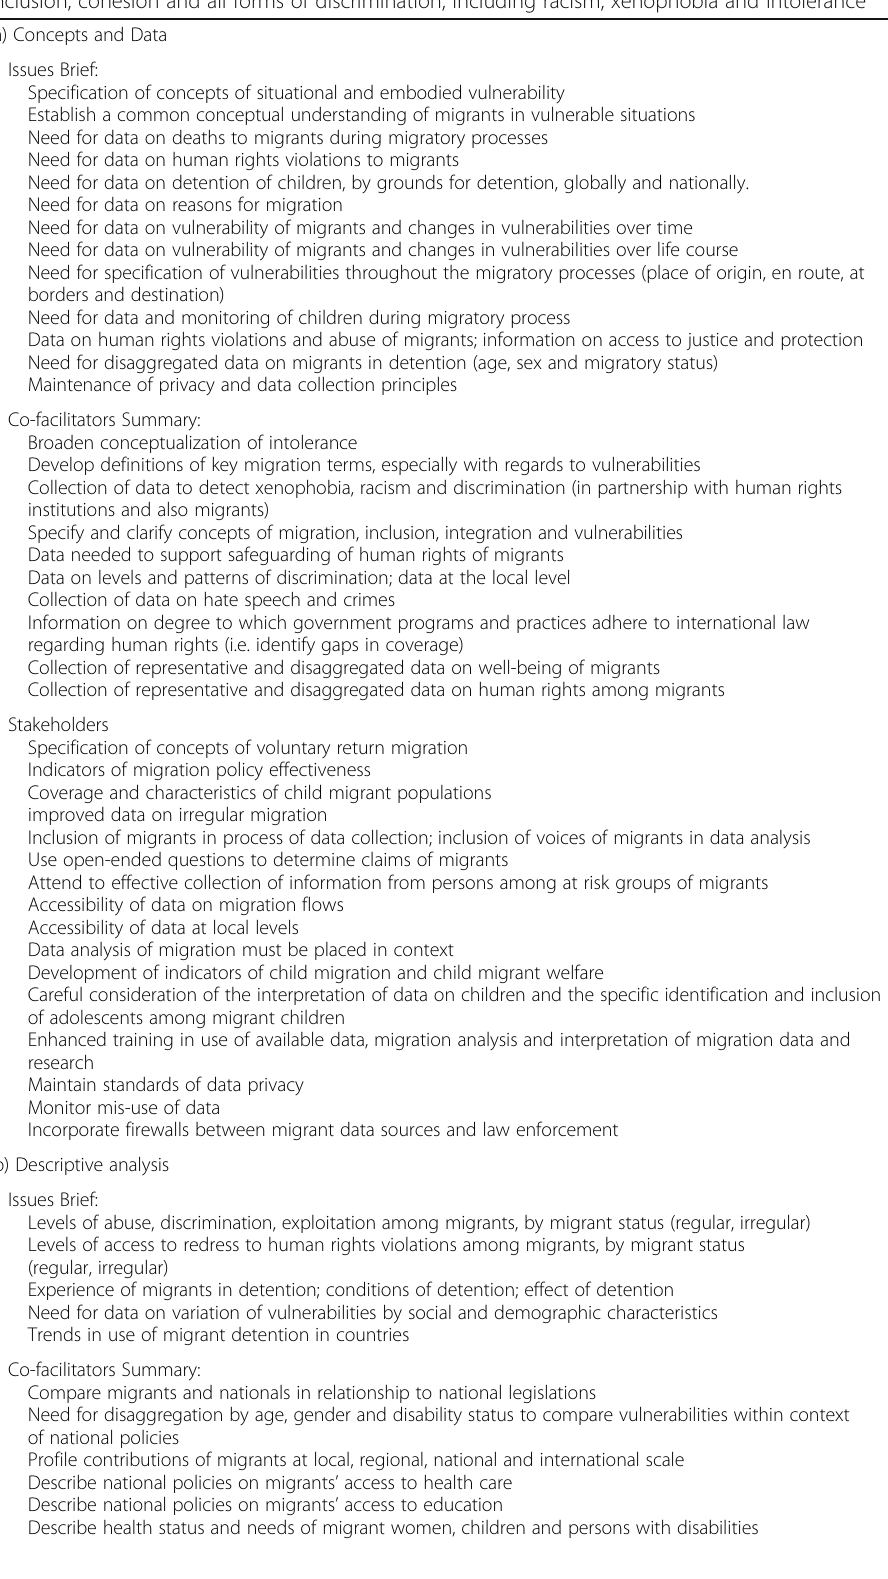
Table 1 Proposals for data and research: Thematic Session I Human rights of all migrants, social inclusion, cohesion and all forms of discrimination, including racism, xenophobia and intolerance (a) Concepts and